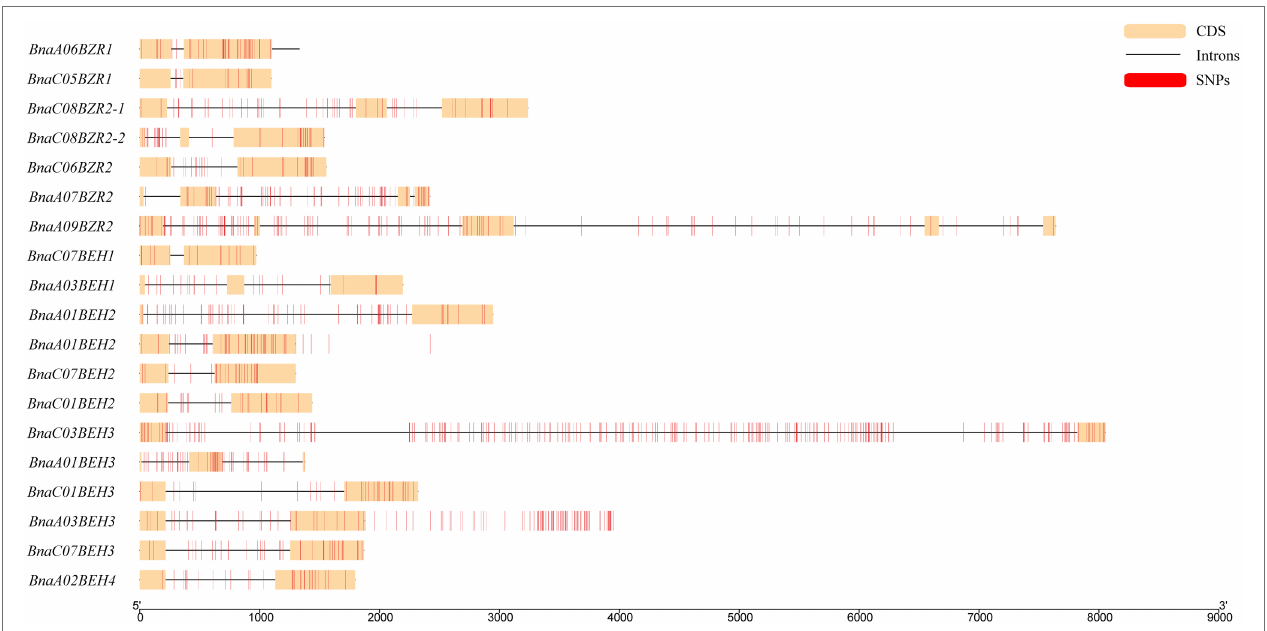
FIGURE 10 | SNPs distribution on coding and non-coding regions of the BnaBZRs. The yellow-colored block represents as the coding sequence, whereas the black lines indicate as the introns, and red-colored block represents as